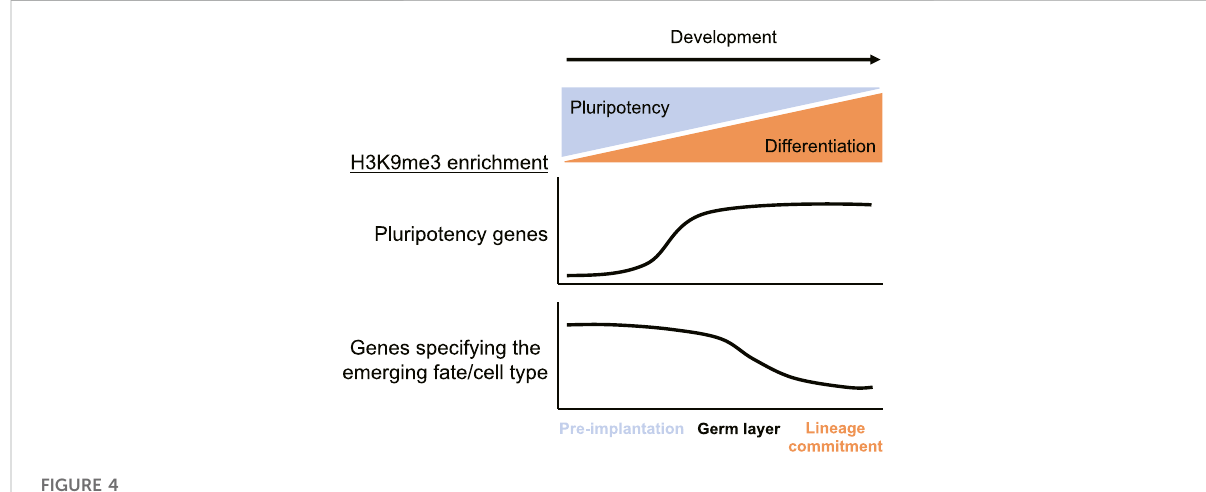
FIGURE 4 H3K9me3 enrichment at pluripotency versus cell type-speci fi c genes throughout development. In early, pre-implantation stages, H3K9me3 is missing from pluripotency genes but highly enriched at cell type-speci fi c genes, which promotes the pluripotency program. As development proceeds into the germ layer stage, H3K9me3 is deposited at pluripotency genes and becomes signi fi cantly lost at cell type-speci fi c genes during lineage commitment to promote tissue speci fi city. H3K9me3 differentially regulates pluripotency and cell type-speci fi c genes to orchestrate the timely progression of developmental